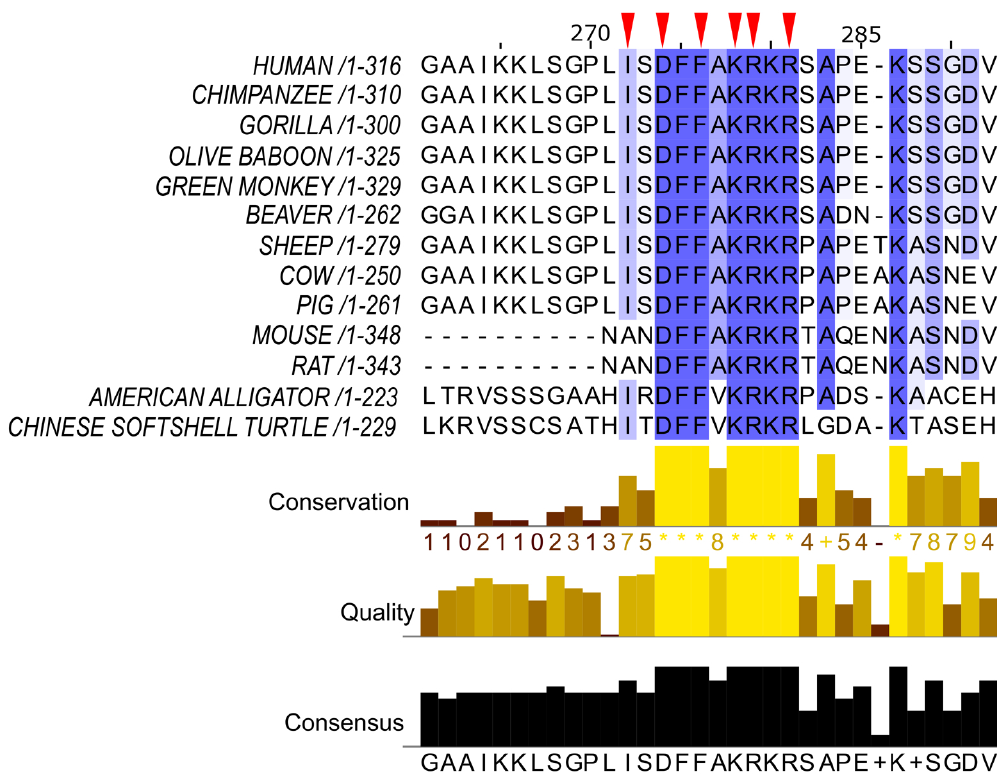
Figure 2. Amino-acid conservancy in the “hot-spot” region of CDKN1C. Red arrowheads represent codons that are mutated in IMAGe syndrome, FGR/IUGR or Silver-Russell syndrome. Yellow asterisks represent complete conservation amongst the species shown.